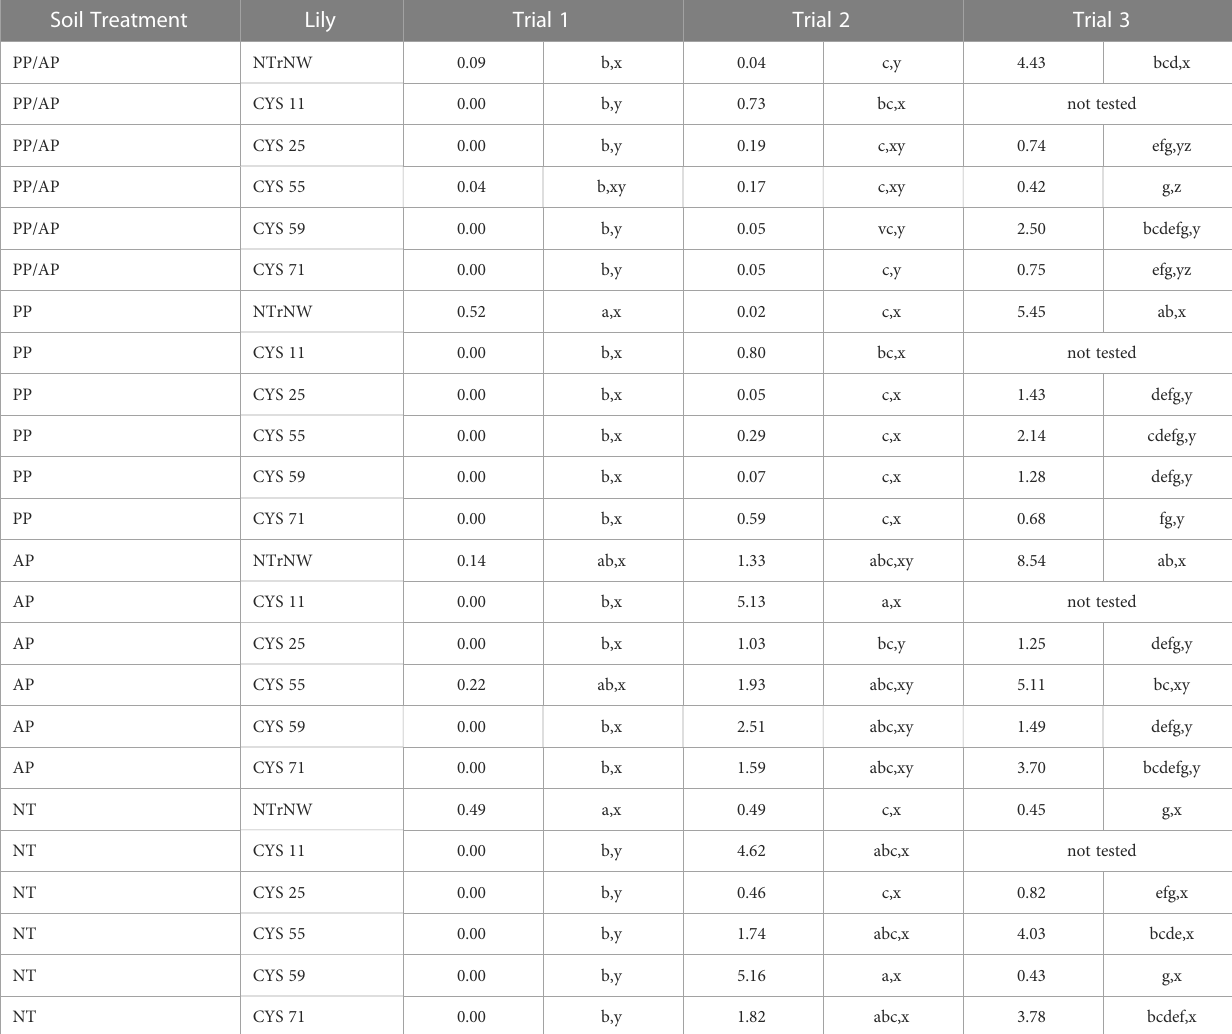
TABLE 1 Densities of lesion nematode ( Pratylenchus penetrans ) per gram of roots at harvest in three fi eld trials conducted in naturally infested soil at the Easter Lily Research Foundation Research Station in Brookings, OR, USA. Soil Treatment Lily Trial